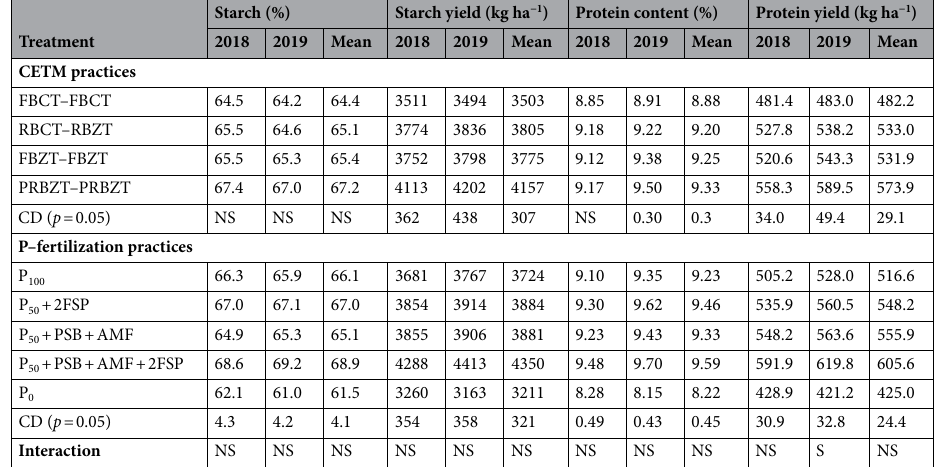
Table 1. Influence of CETM and P-fertilization practices on grain starch content (%), starch yield (kg ha −1 ), protein content (%) and protein yield (kg ha −1 ) in maize under MWCS. CD values indicate the critical difference at p =